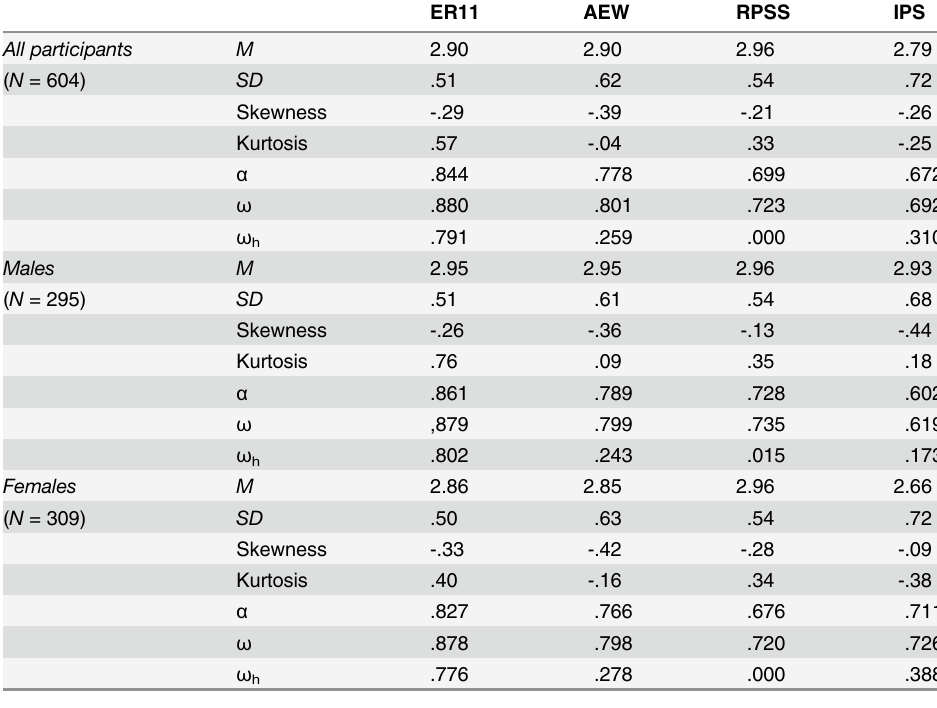
Notes : α = Cronbach ’ s alpha